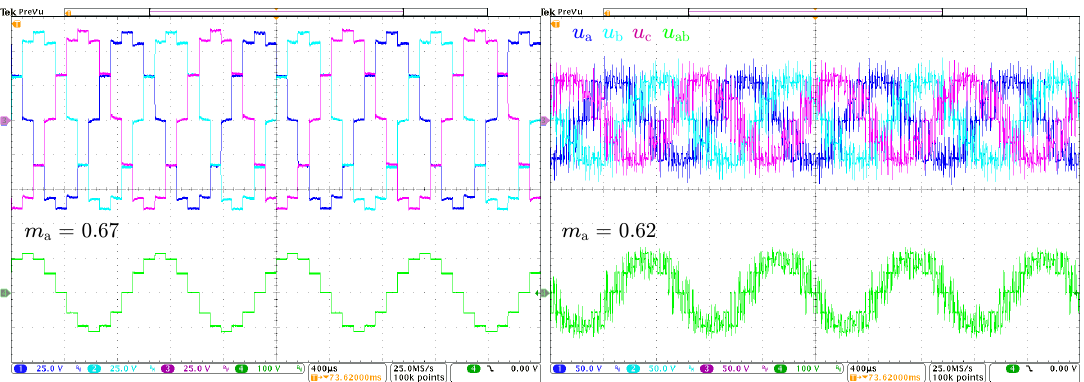
Figure 13. The output phase, leg, and coil N B voltages and phase currents of the 12-pulse modular VSI with two-level modules for CQ-PAM control.